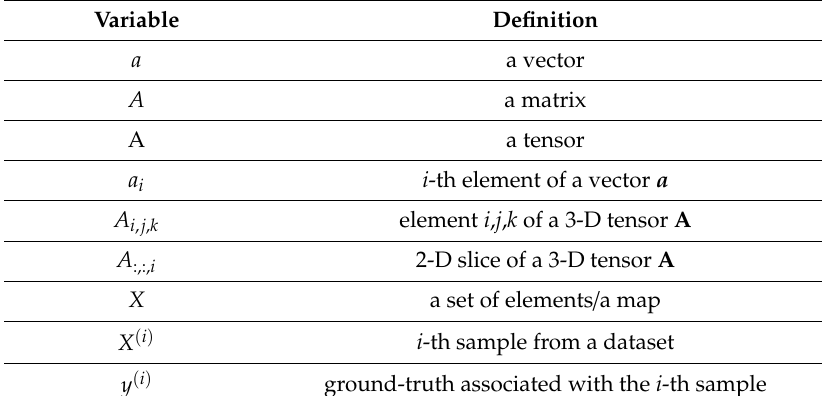
Table 1. Adopted mathematical